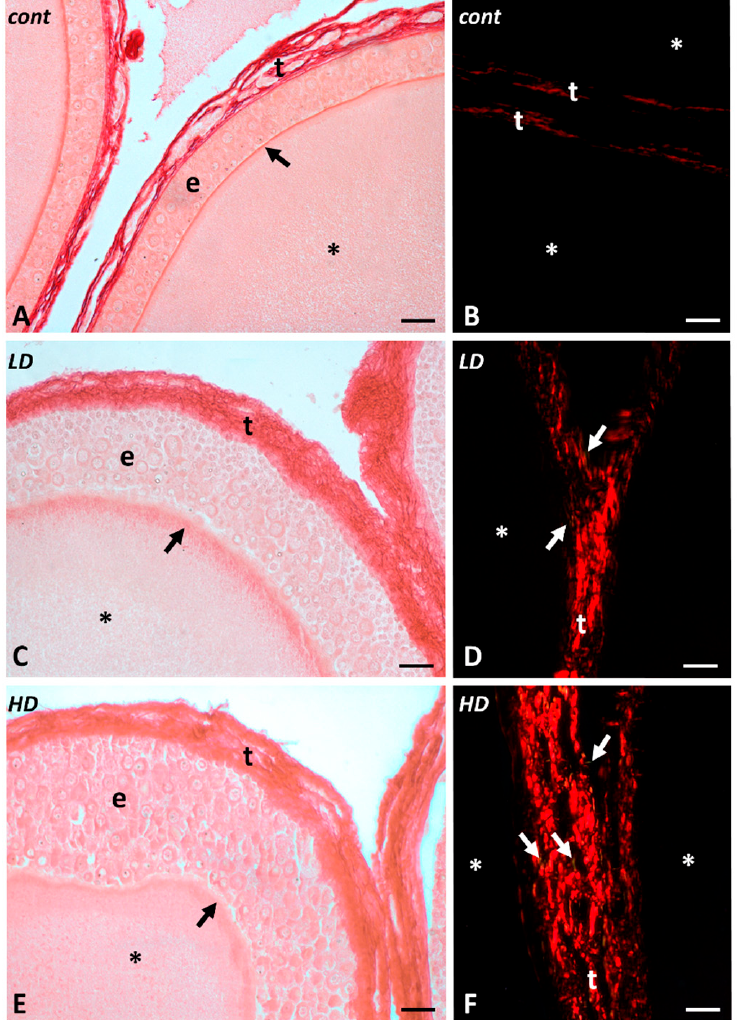
Figure 2. Collagen localization in P. siculus follicles exposed to glyphosate (low LD and high HD doses). Picrosirius red staining observed under bright-field light (left panels) or polarized light (right panels). ( A , C , E ) Progressive thickening and compaction of the connective theca (t). Epithelium (e), zona pellucida (arrows), and oocyte cytoplasm (*). ( B , D , F ) Progressive increase in mature (red) and immature (green, arrows) fibers in connective theca. Scale bars 20 µ m. PSR staining observed under polarized light allows recognition of thin immature collagen fibers (collagen III, green stained) from the thick mature collagen fibers (collagen I, red stained). The results indicate that immature and mature collagens increased dose- dependently in treated samples with respect to controls (Figure 2B,D,F, respectively, and Figure 3A). Newly deposited immature collagen fibers are also found in both low- and high-dose-treated samples, suggesting the presence of poorly packed collagen fibers in the interstitial area of the theca (Figure 3A). Of note, quantitative analysis of collagen fibers’ diameter reveals that the collagen network of high-dose-treated samples is densely packed, with a mean fiber diameter of 1.7 ± 0.47 µ m SD. Likewise, a low dose of glyphosate induces an increase in collagen fiber diameter (1.43 ± 0.33 mm SD) compared with the control groups (1.03 ± 0.25 mm SD) (Figure 3B). A large effect size (>0.8) was reported between the analyzed